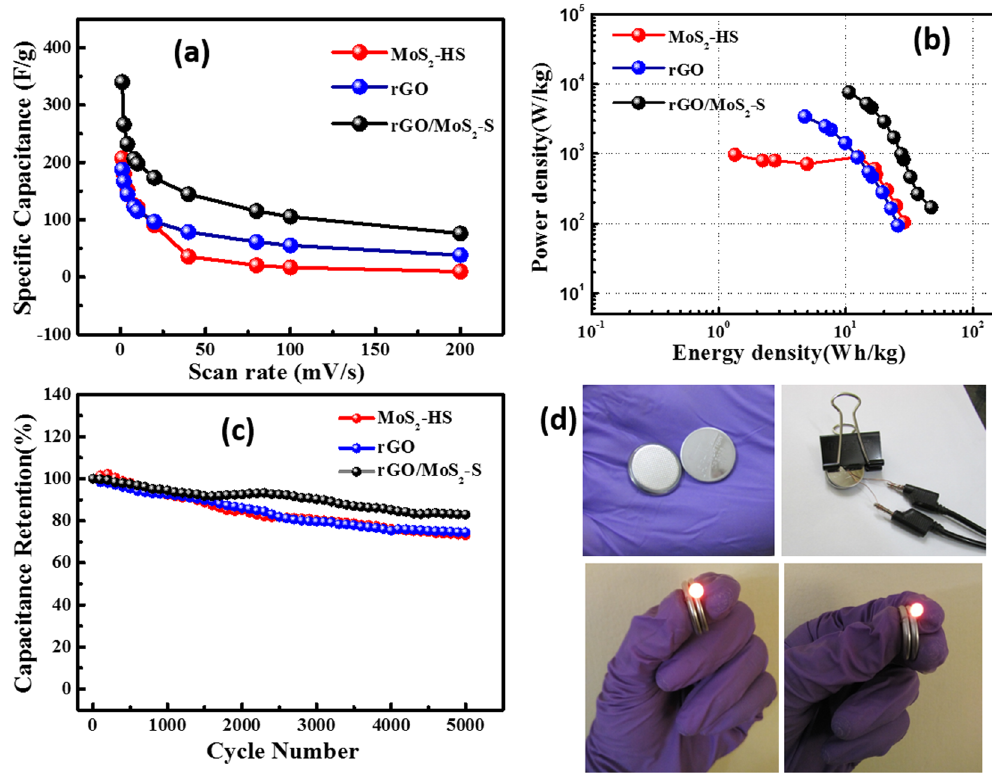
Figure 7. ( a ) Plot of specific capacitance vs. scan rates, ( b ) Ragone plot (energy density vs power density) ( c ) Plot of capacitance retention at different cycles of MoS 2 -HS, rGO and rGO/MoS 2 -S hybrid and ( d ) Photograph demonstrating the powering of a red LED with a stack of two coin cell type supercapacitor device fabricated from rGO/MoS 2 -S